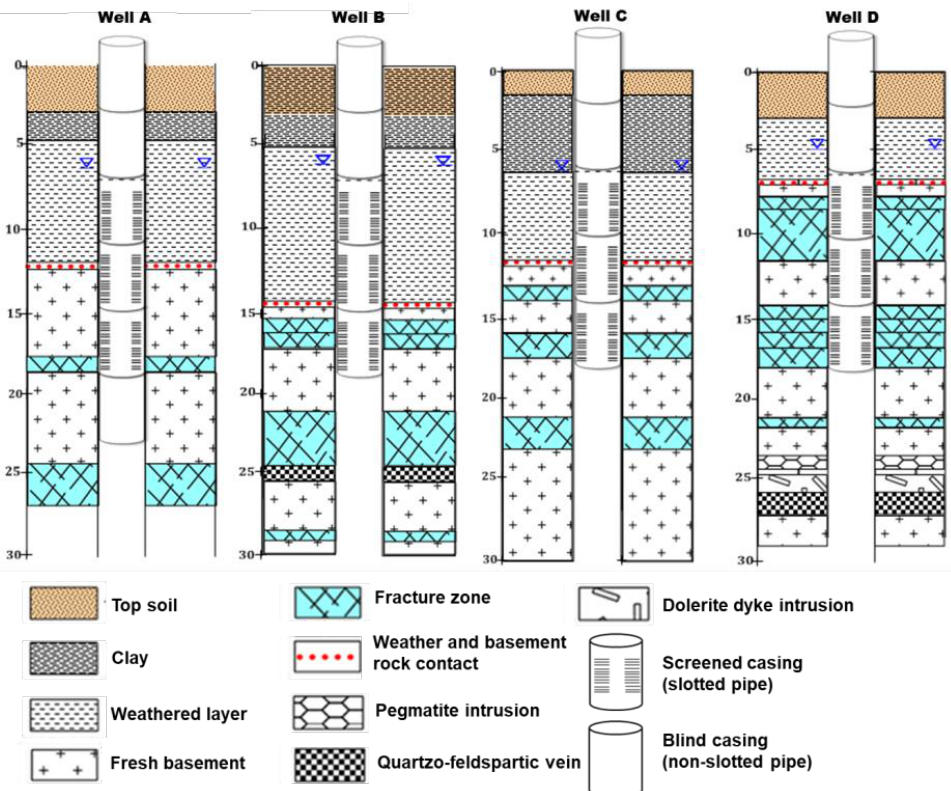
Figure 4. Lithological profiles and well design for all four wells (wells A, B, C, and D). The lithological logs were created from drill cuttings obtained every 1 m or when changes occurred in sediment types during drilling.